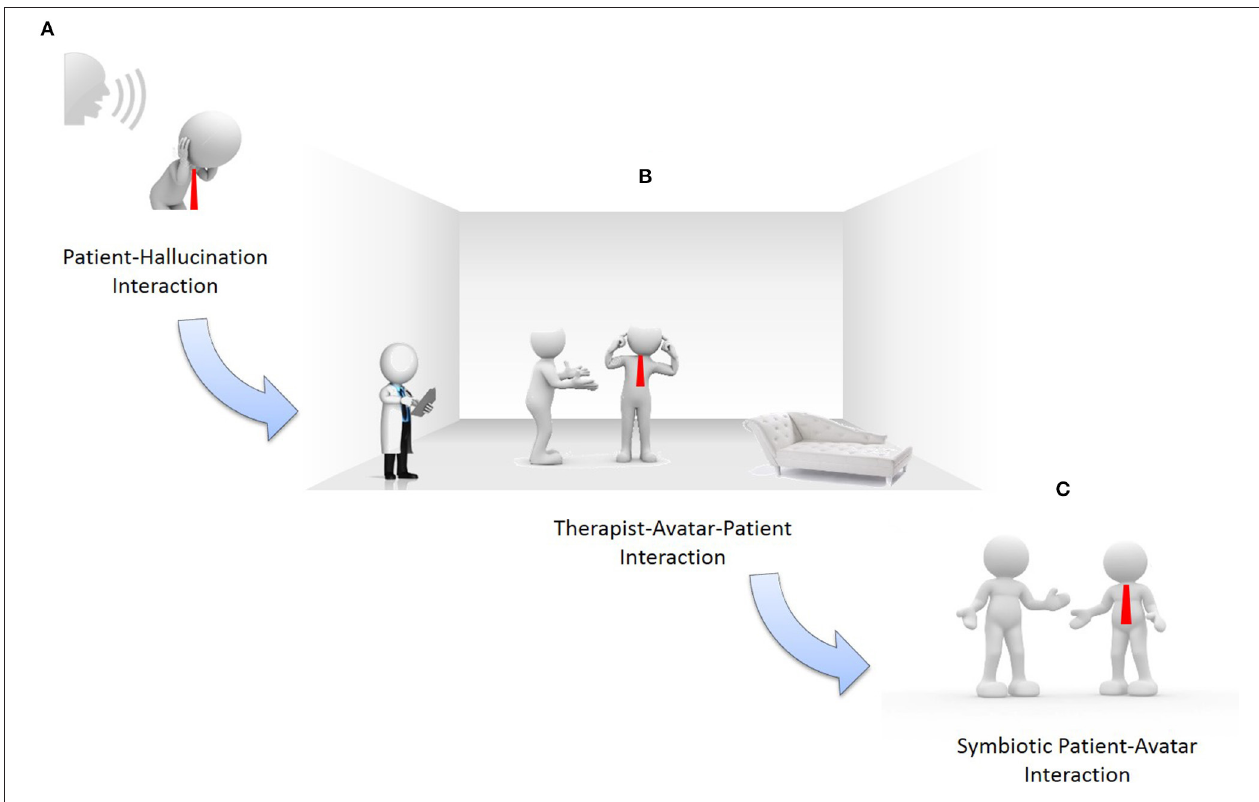
FIGURE 1 | Evolving to symbiotic human-avatar interaction. (A) patient-hallucinations interaction; (B) therapist-avatar-patient interaction; (C) symbiotic patient-avatar